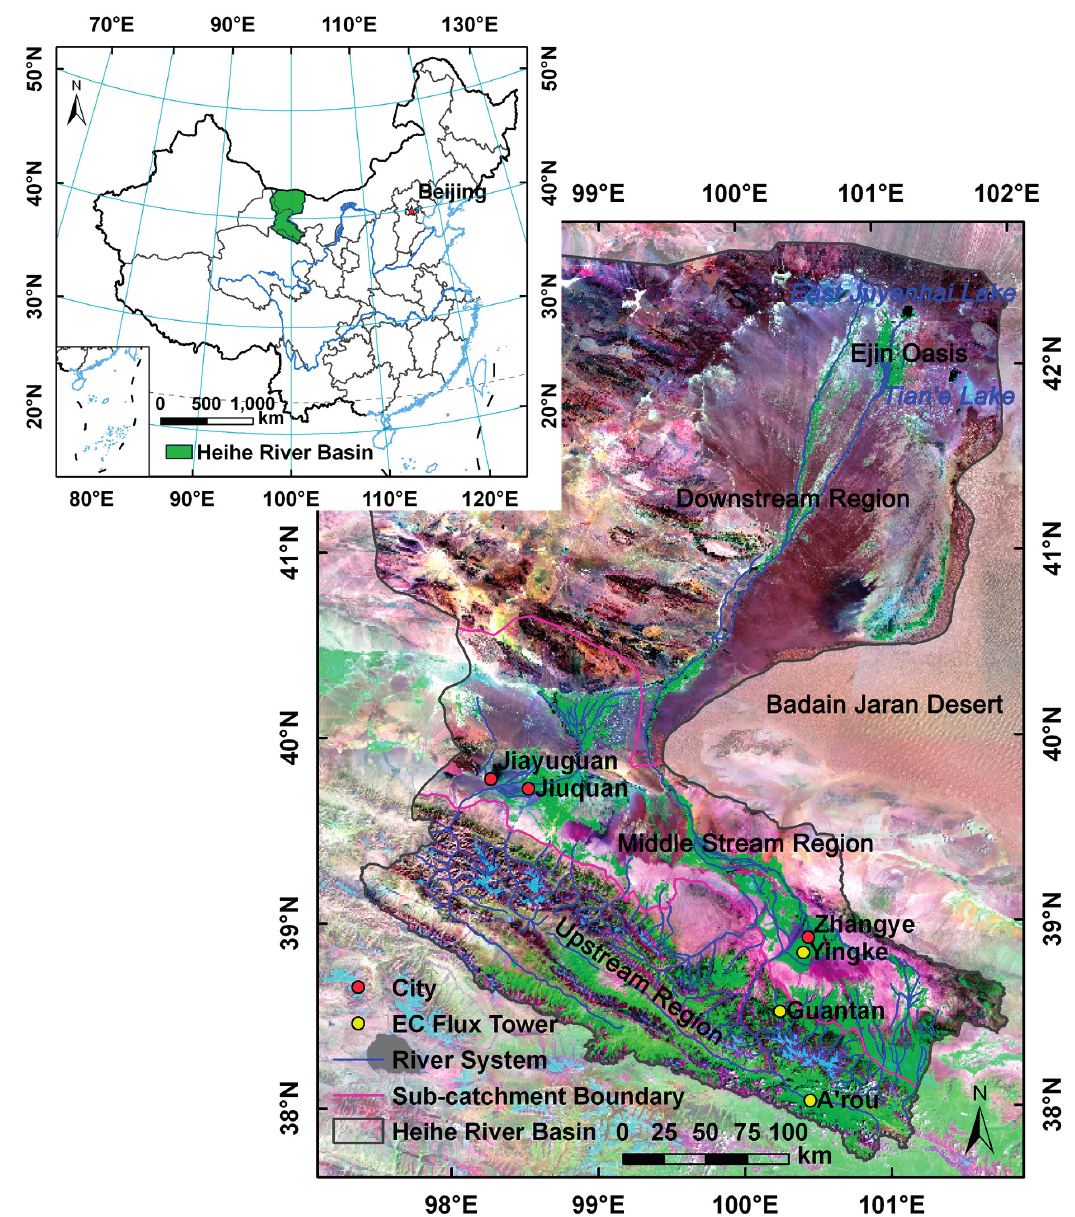
Figure 1. Locations of the Heihe River basin and the eddy covariance (EC) flux sites. The color composite remote sensing imagery of the landscape is mosaicked from Landsat-5 Thematic Mapper (TM) and Landsat-7 Enhanced Thematic Mapper Plus (ETM+) sensors (Red/band 7, Green/band 4, and Blue/band